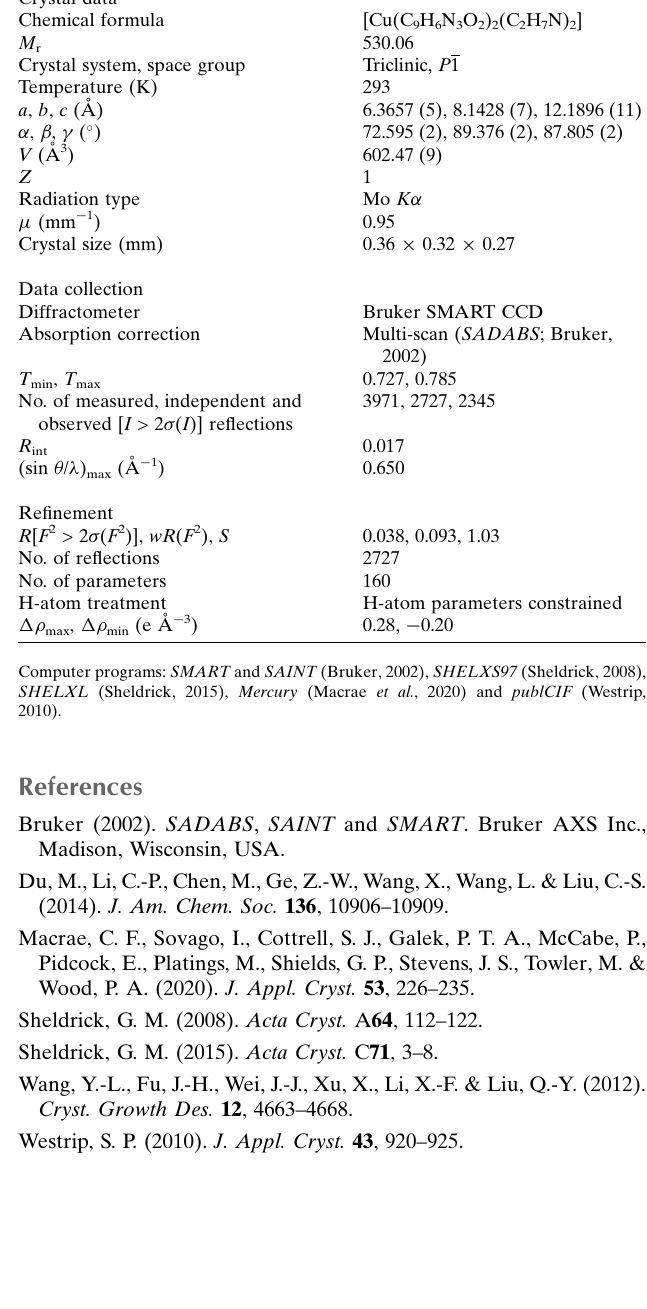
Table 2 Experimental details. Crystal data Chemical formula